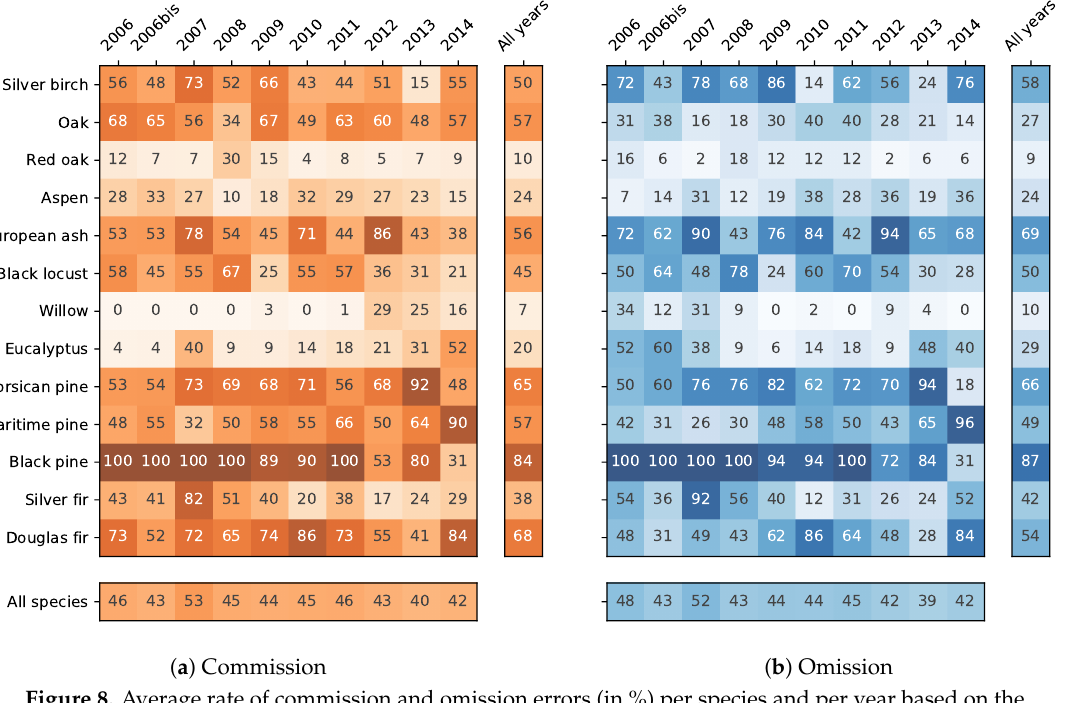
Figure 8. Average rate of commission and omission errors (in %) per species and per year based on the SLOO-CV sampling